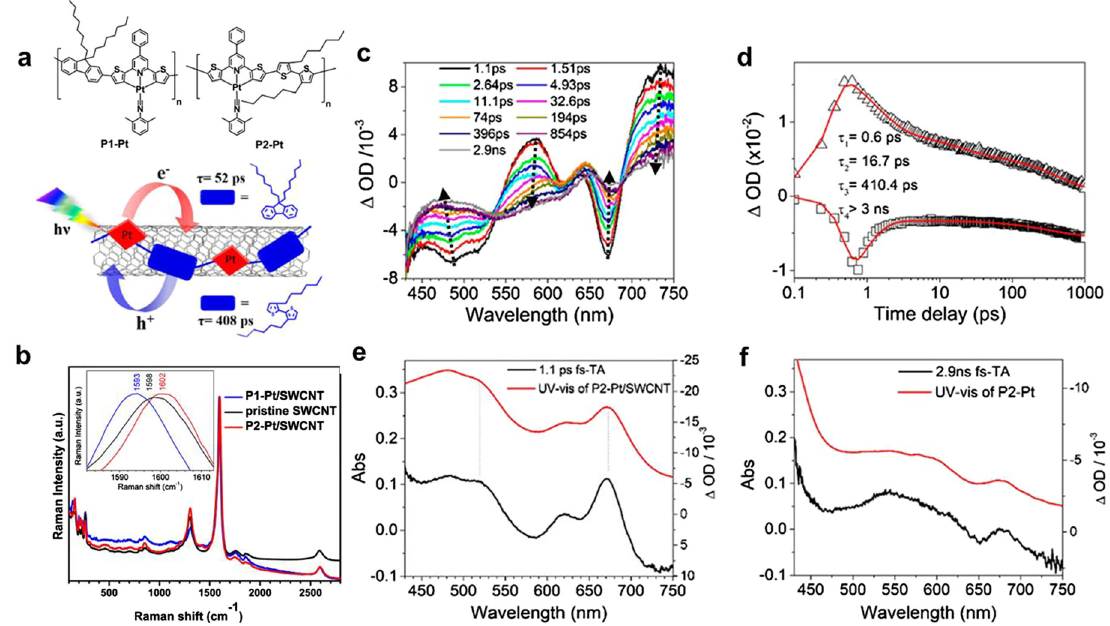
Figure7: (a)Polymerstructuresandschematicpresentationofpolymer/SWCNT hybrids;(b)micro-Ramanspectraof pristineSWCNTs(black), P1 – Pt/SWCNT (blue) and P2 – Pt/SWCNT (red) (excited at 785 nm); (c) fs-TA of P2 – Pt/SWCNT in THF solution acquired after 400 nm irradiation; (d)kinetictracesat730nm(blacktriangle),530nm(blacksquare)andtherespective fi ttingtraces(solidlines,red)basedonaglobalanalysis with four exponential functions; (e) comparison between the UV – vis spectra of P2 – Pt/SWCNT with the transient absorption spectrum at 1 ps; (f)comparisonbetweentheUV – visspectraofP2 – Ptwiththetransientabsorptionspectrumat3ns[65].SWCNT,single-wallcarbonnanotube; fs-TA, femtosecond transient